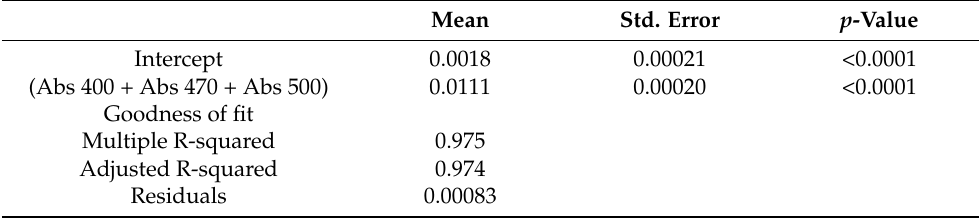
Table 3. Parameter estimates of the linear regression model of concentration and absorbance of quinoa flour samples fermented by Monascus purpureus supplemented with fish hydrolysate and sodium